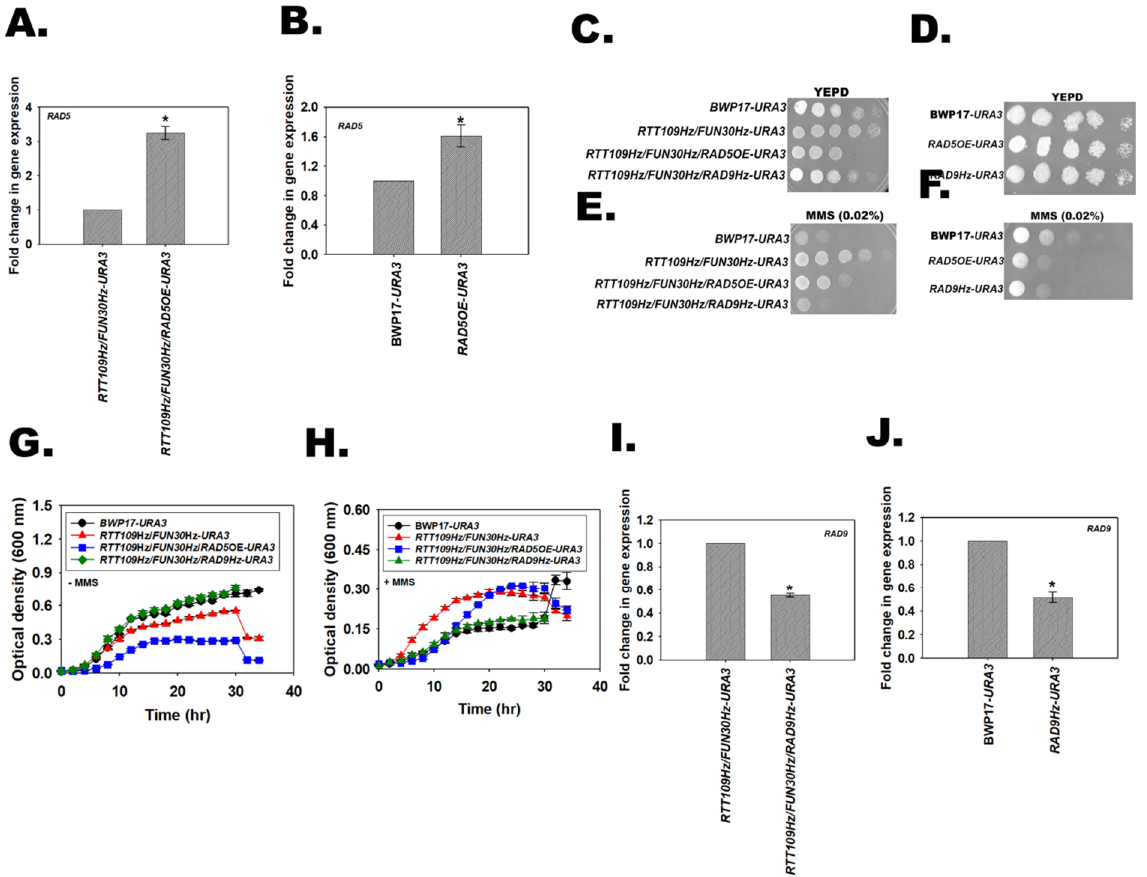
Figure 8. RAD9 deletion in RTT109Hz/FUN30Hz rescues the resistance to MMS . ( A ). Expression of RAD5 was analyzed in RTT109Hz/FUN30Hz-URA3 and RTT109Hz/FUN30Hz/RAD5OE-URA3 using qPCR. ( B ). Expression of RAD5 was analyzed in BWP17- URA3 and RAD5 overexpression ( RAD5OE-URA3 ) strain. ( C ). Growth of BWP17 -URA3 , RTT109Hz/FUN30Hz-URA3 , RTT109Hz/FUN30Hz/RAD5OE-URA3 , and RTT109Hz/FUN30Hz/RAD9Hz-URA3 on YEPD plate. ( D ). Growth of BWP17- URA3 , RAD5OE-URA3 , and RAD9Hz-URA3 on YEPD plate. ( E ). Sensitivity of BWP17 -URA3 , RTT109Hz/FUN30Hz-URA3 , RTT109Hz/FUN30Hz/RAD5OE-URA3 , and RTT109Hz/FUN30Hz/RAD9Hz-URA3 to MMS (0.02%) was evaluated using plate assays. ( F ). Sensitivity of BWP17- URA3 , RAD5OE-URA3 , and RAD9Hz-URA3 to MMS (0.02%) was evaluated using plate assays. Growth curve of BWP17 -URA3 , RTT109Hz/FUN30Hz-URA3 , RTT109Hz/FUN30Hz/RAD5OE-URA3 , and RTT109Hz/FUN30Hz/RAD9Hz-URA3 in the ( G ). absence and ( H ). presence of MMS (0.02%). ( I ). The expression of RAD5 9 was analyzed in RTT109Hz/FUN30Hz-URA3 and RTT109Hz/FUN30Hz/RAD9Hz-URA3 strains using qPCR. ( J ). Expression of RAD5 9 was analyzed in BWP17 -URA3 and RAD9Hz-URA3 strains using qPCR. The qPCR data are presented as average ± s.e.m. of three biological replicates. * p < 0.05. In the case of plate assays, five-fold serial dilutions were prepared and spotted on respective plates. The plates were incubated at 30 °C and imaged after 24 h.